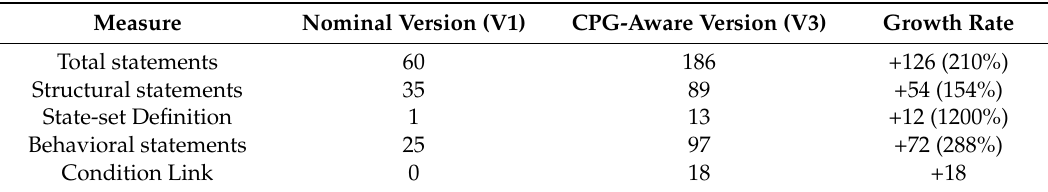
Table 4. TMI2 Comparative Analysis of Model Versions.